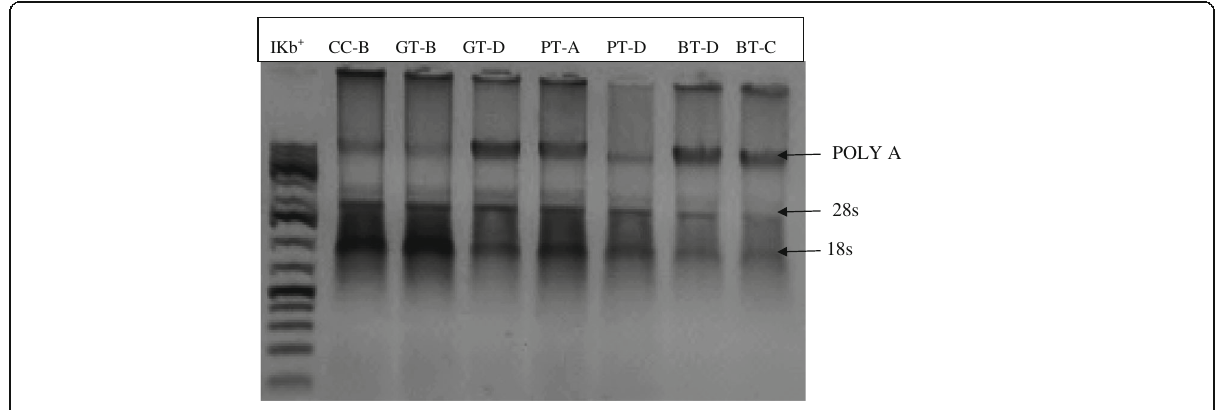
Fig. 6 Gel electrophoresis image of mRNA from cells treated with the representative tea samples